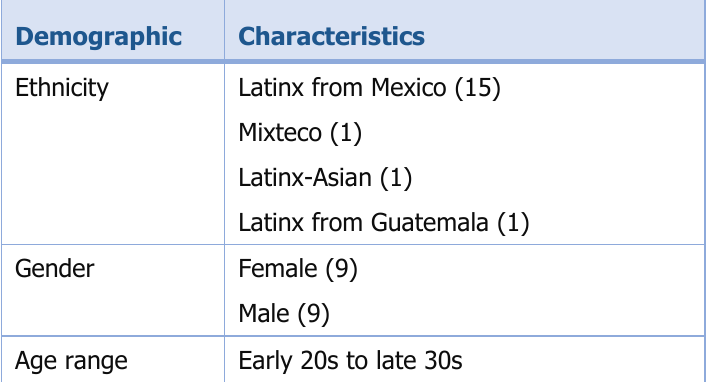
Table 2. Staff Interviewee Demographics